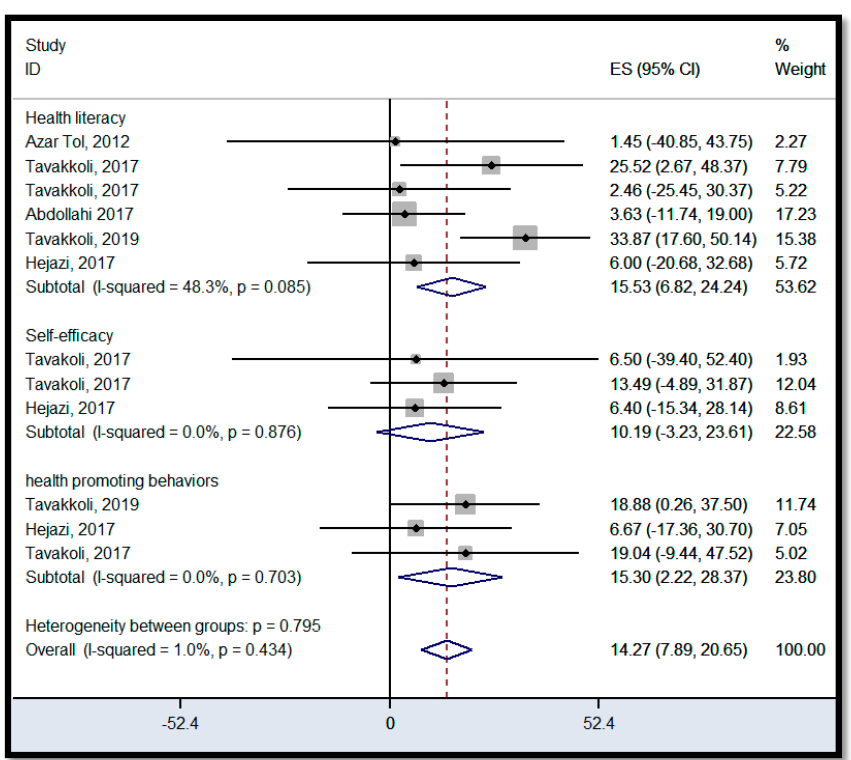
Figure 6. Forest plot for the intervention outcome. ES: effect size, I 2 : a measure of the ratio of the total variation in study measures due to heterogeneity, p > 0.05: devastates heterogeneity is appropriate for interpretation.